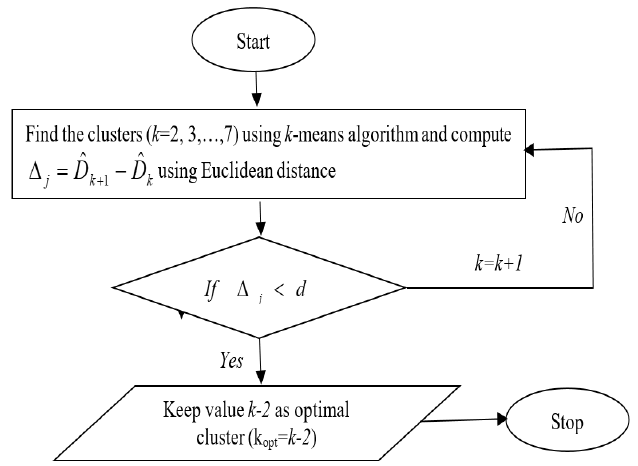
Fig. 1. Structure of proposed k-means clustering algorithm